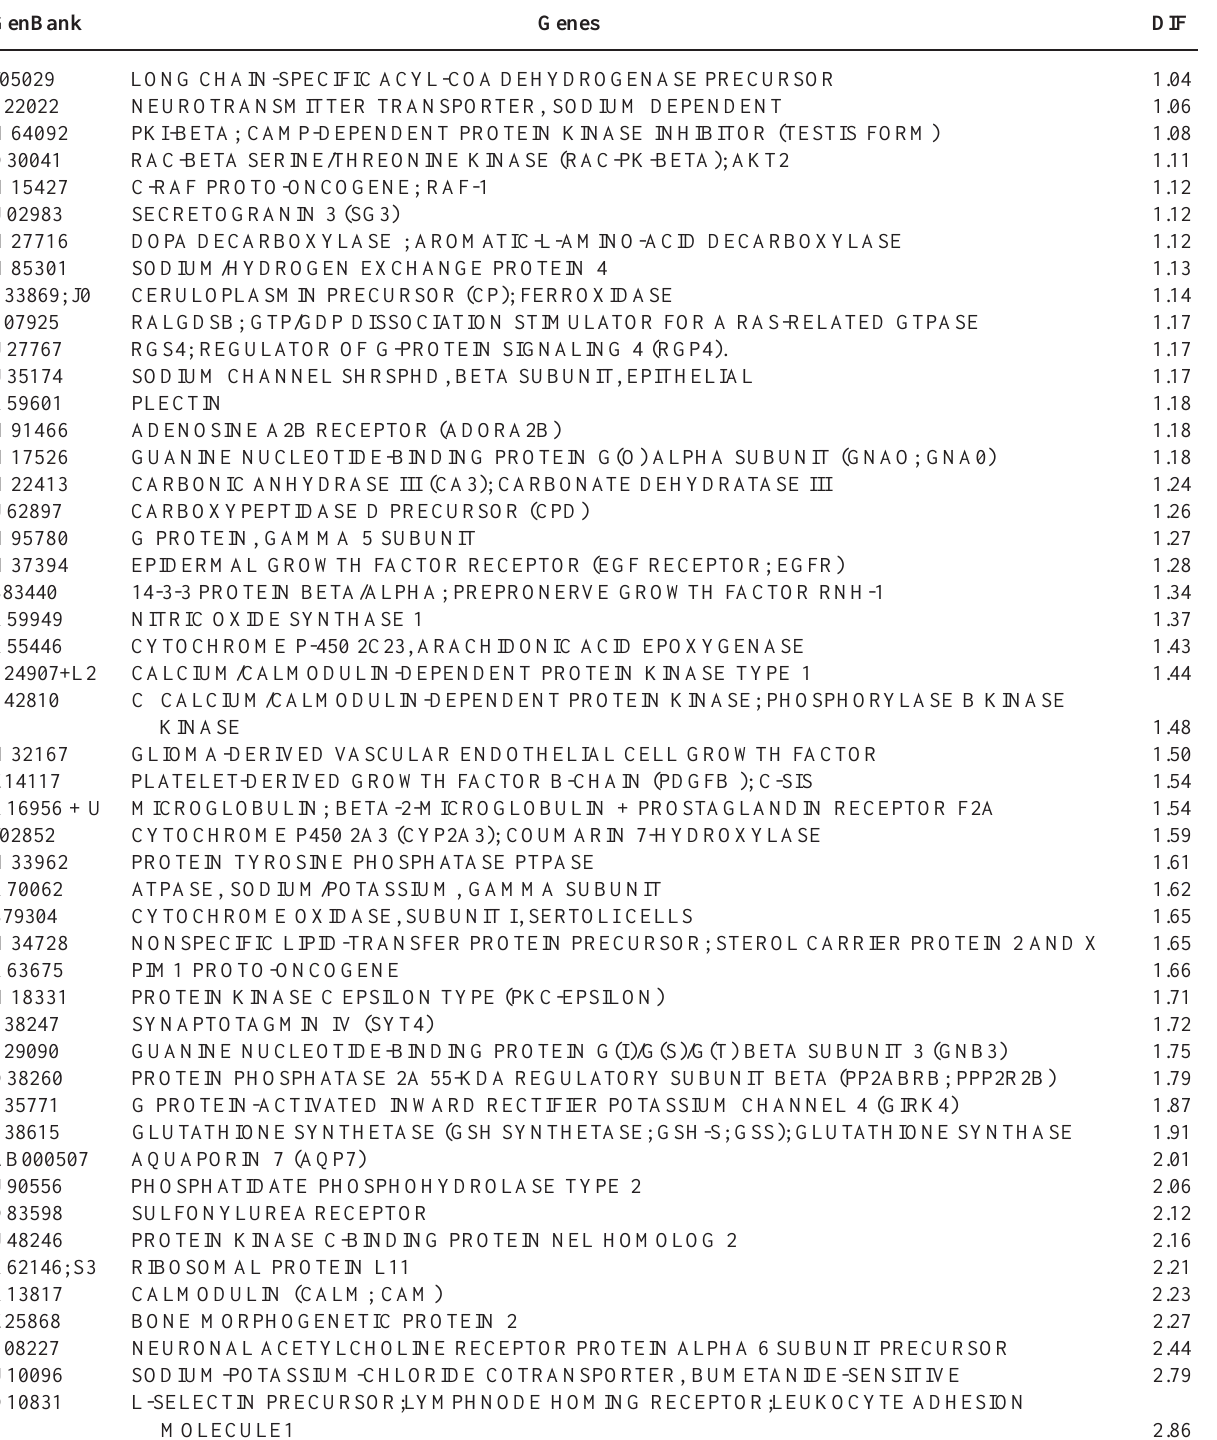
Table 2 – Genes lower expressed in Group